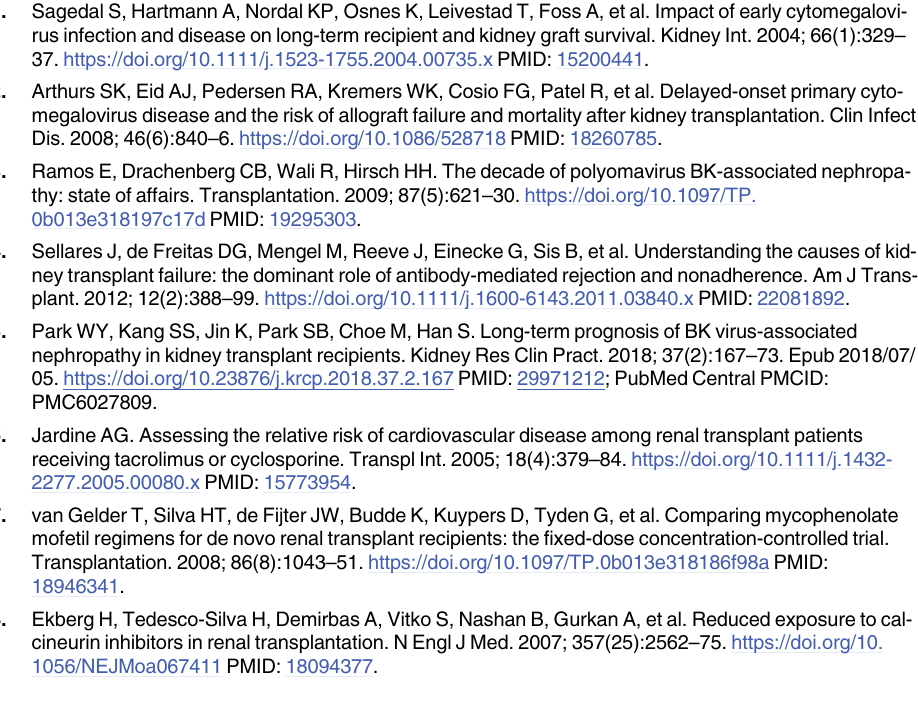
S1 Table. Number of renal and cardiovascular outcomes after 1 year post-transplant. S2 Table. Multivariate Cox regression analysis for BPRA or